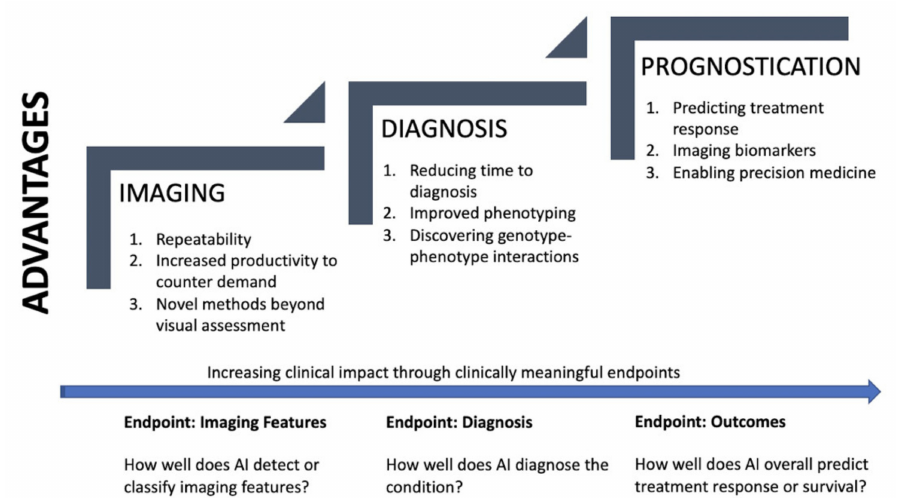
Figure 7. Summary figure. Domains of AI application with corresponding advantages. Increasing clinical impact through clinically meaningful